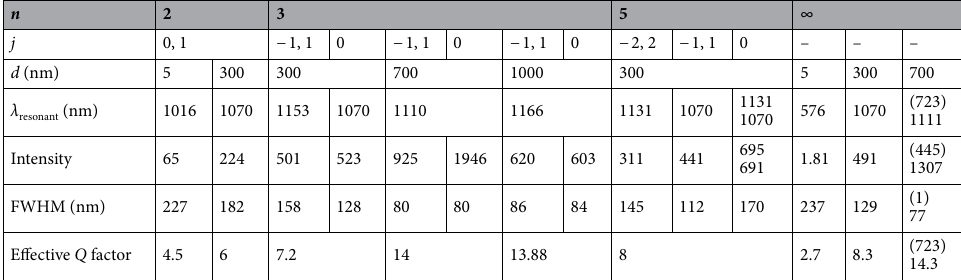
Table 1. Resonance wavelength, intensity, FWHM, and effective Q factor for uniform lamellar gratings with w = 15 nm, Δ = 0, L = 100 nm, n > 1. Note that bi-wavelength localization is achieved at d = 300 nm for n = 3 and 5, and d = 700 nm for a periodic structure, whereas at larger values of d uni-wavelength localization is